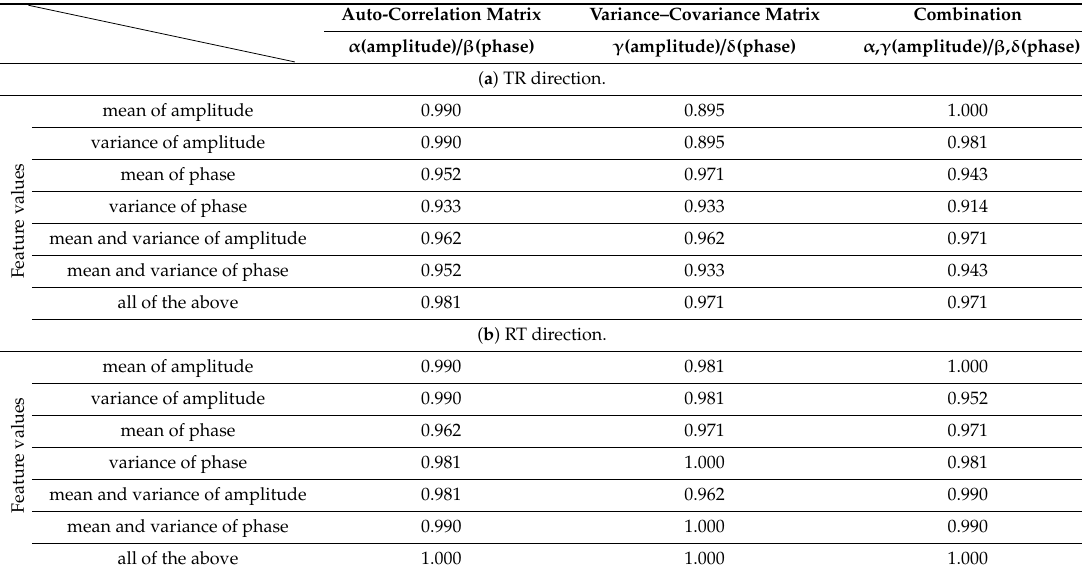
Table 2. Prediction accuracy when using the length of the final passing section and CSI. The values denote the predicted accuracy.